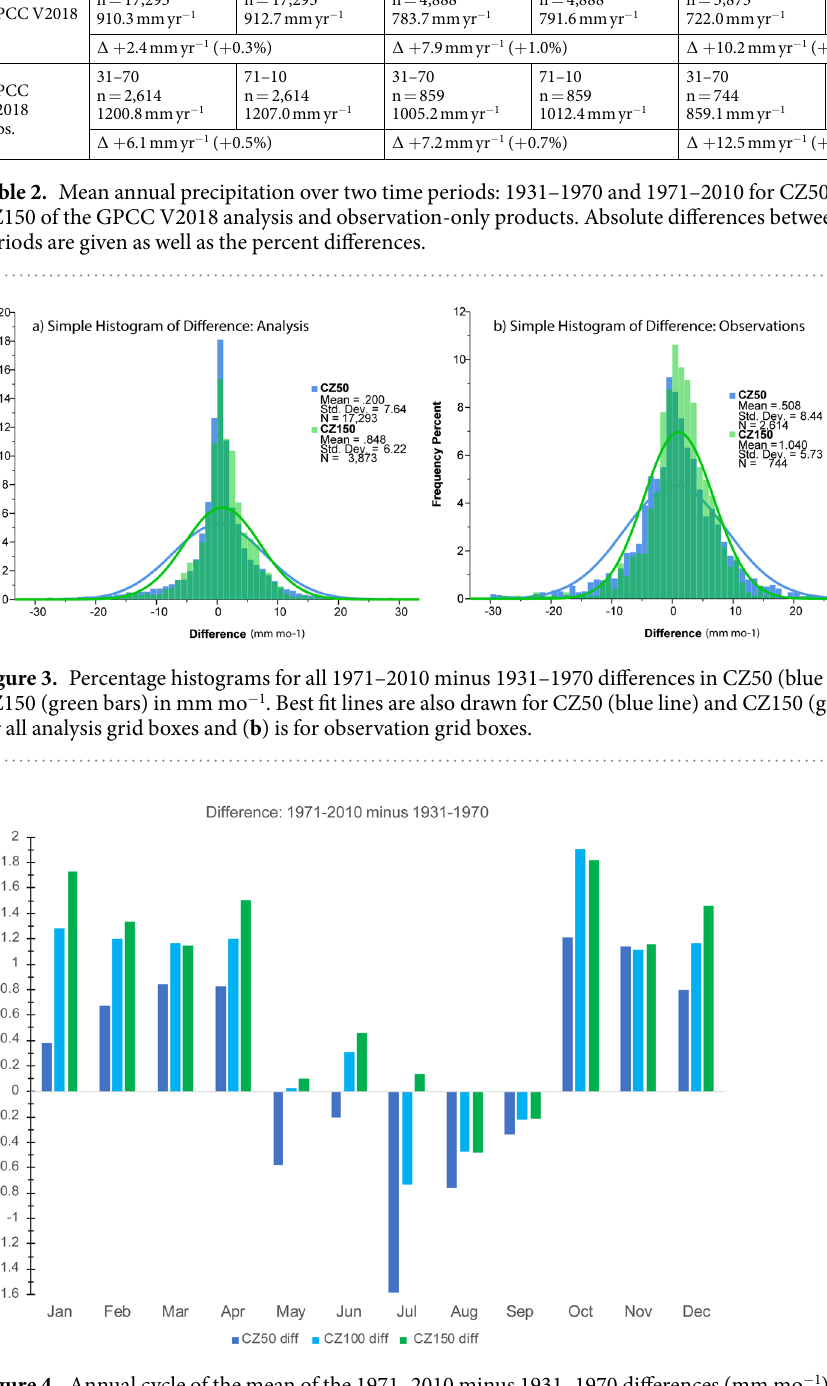
Figure 4. Annual cycle of the mean of the 1971–2010 minus 1931–1970 differences (mm mo − 1 ) in CZ50 (blue), CZ100 (cyan), and CZ150